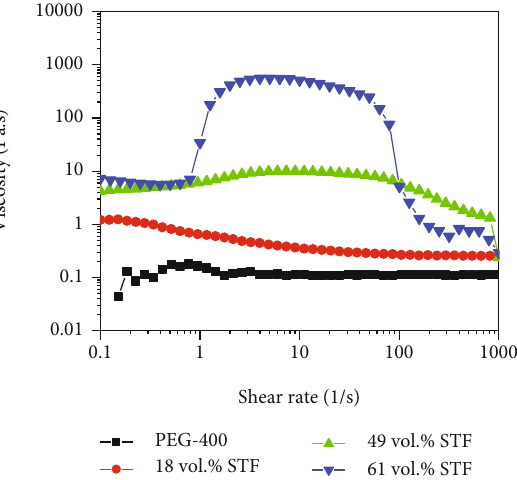
Figure 4: The steady-state shear rheological curve of PEG-400, 18vol.% STF, 49 vol.% STF, and 61vol.%